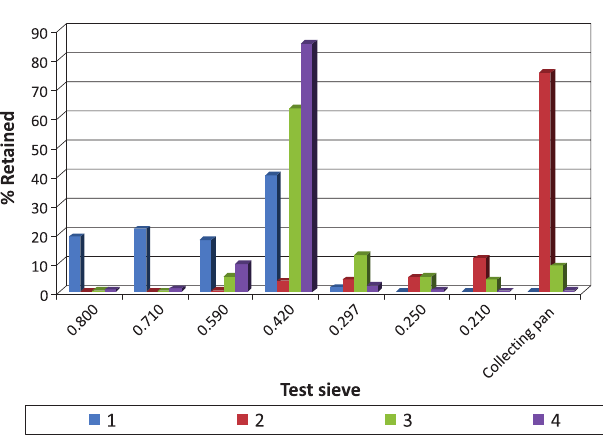
FIGURE 1 - Granulometric distribution of the pellets obtained using PVP (1), PEG 1500 (2), HPMC (3) and MC (4) as binders.